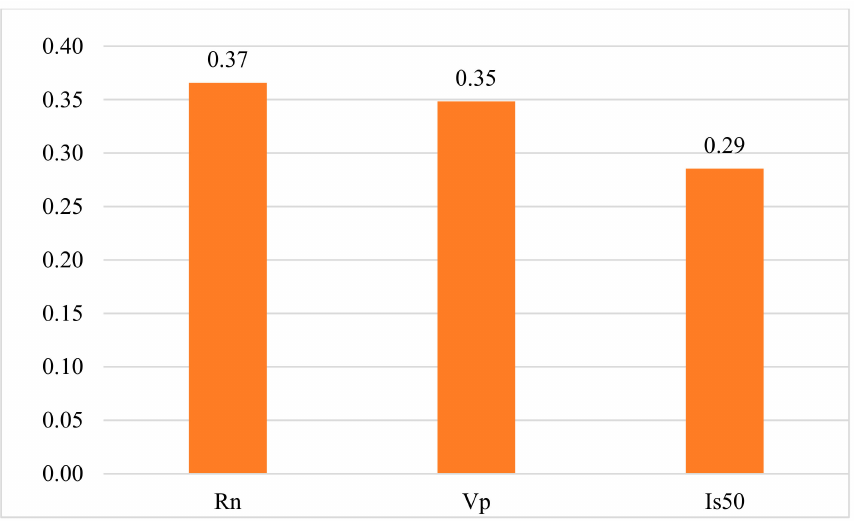
Figure 7. Input variable’s importance to predict the BI derived from the RF